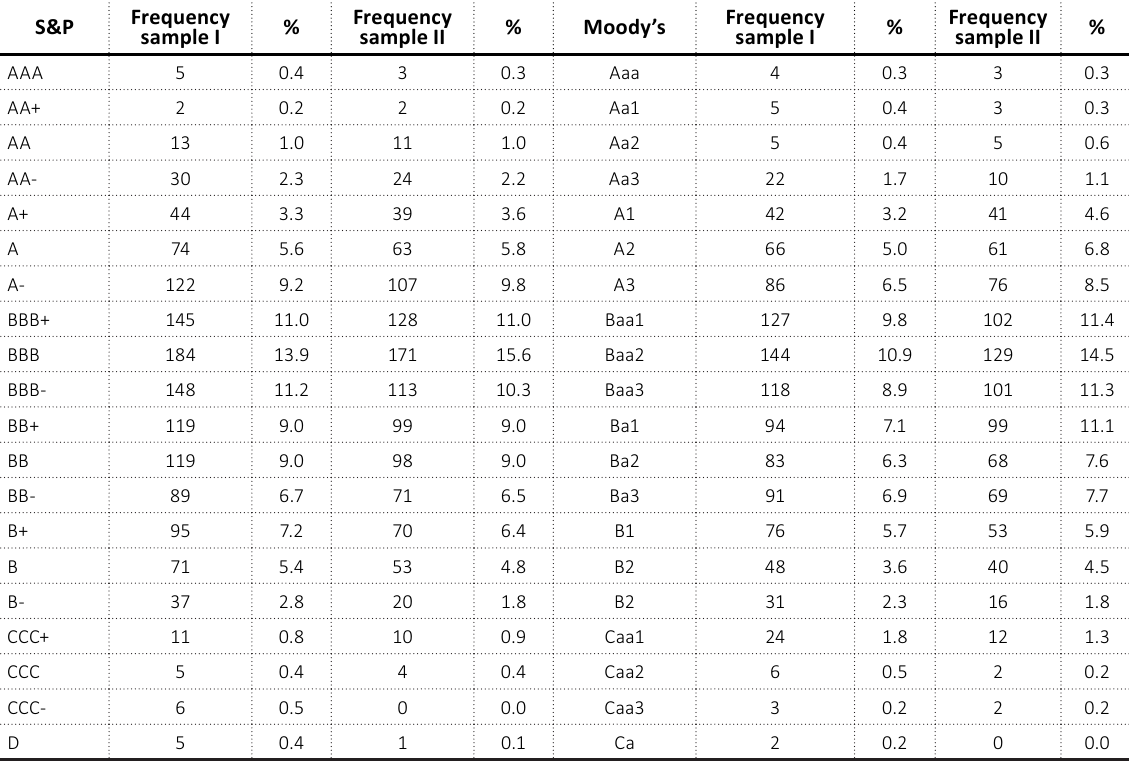
Table 2. S&P and Moody’s rating distributions in samples I and